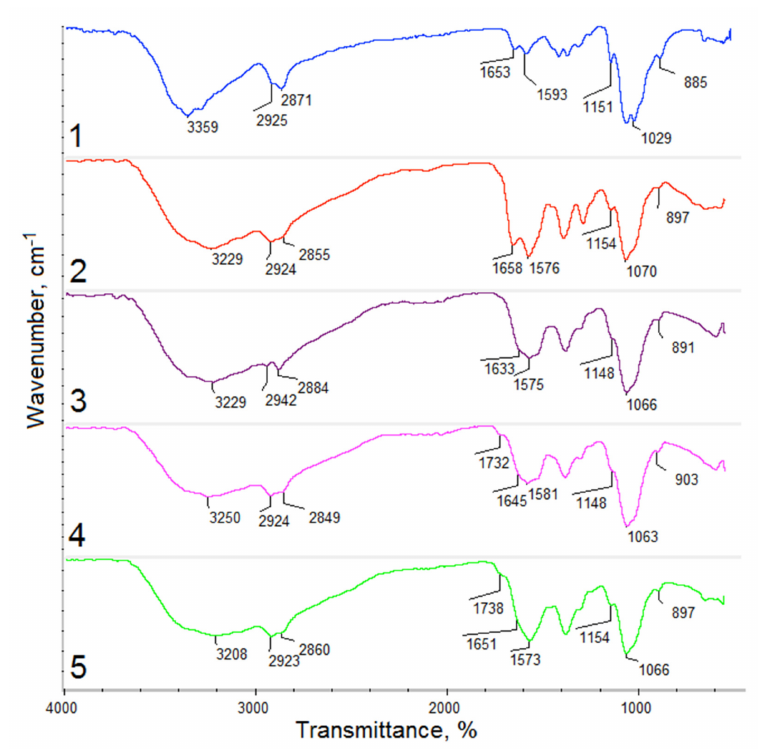
Figure 7. FTIR spectra of the raw fungal chitosan ( 1 ), Gel-1 ( 2 ), Gel-2 ( 3 ), Gel-3 ( 4 ), and Gel-4 ( 5 ) samples containing plant extract prepared using commercial Kalanchoe pinnata